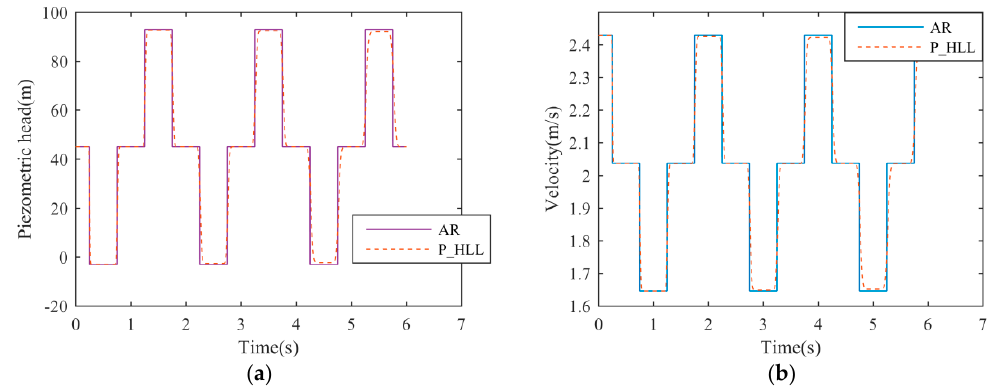
Figure 19. Locus of the flow states at the midpoint of pipe simulated by P_HLL ( P a = 1 and P b = 0.8)